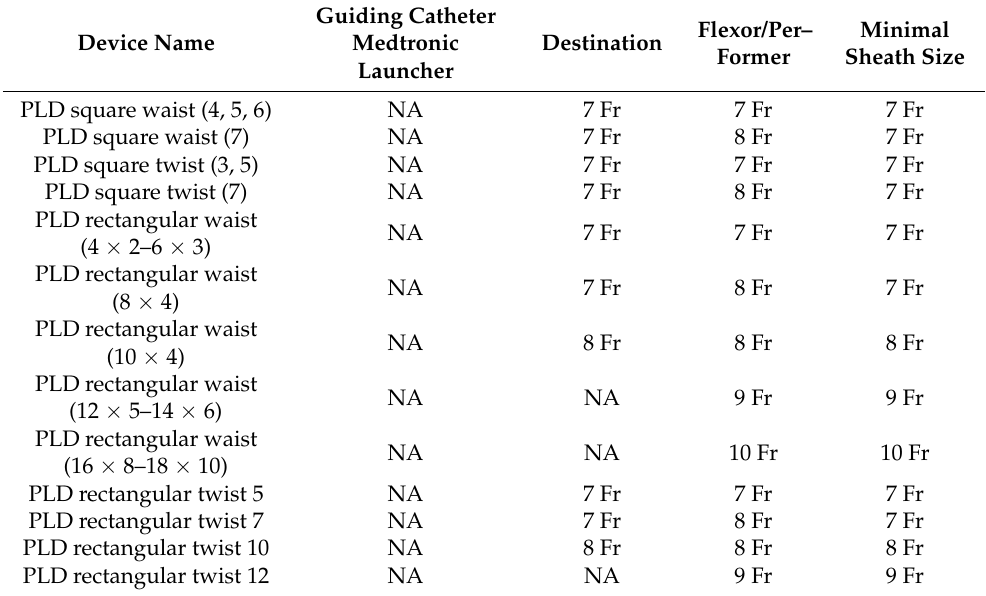
Table 8. The list of PLD devices used in the 3 registries with their compatibility with various delivery